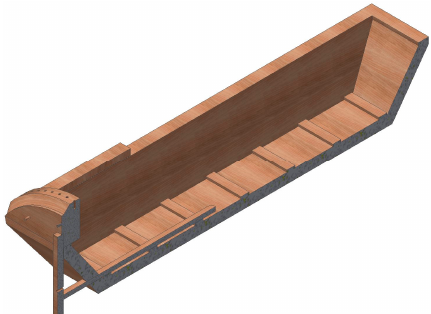
Figure 6 . Axonometric view of the boat in longitudinal section.